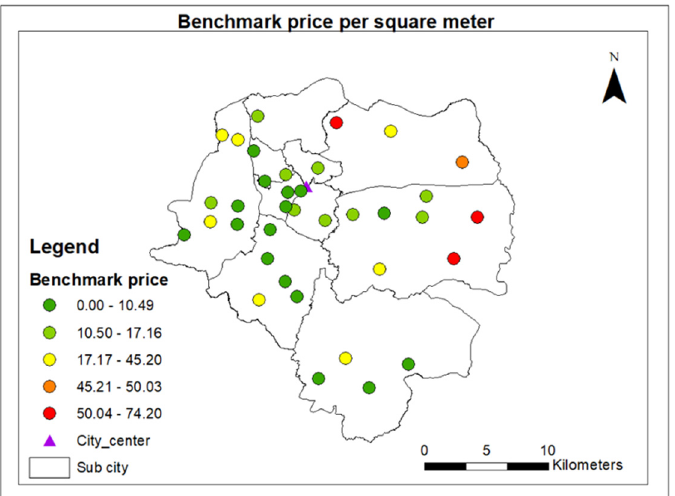
Figure 14. Benchmark urban land prices per m 2 in USD against the distance from the city economic center by Woredas.